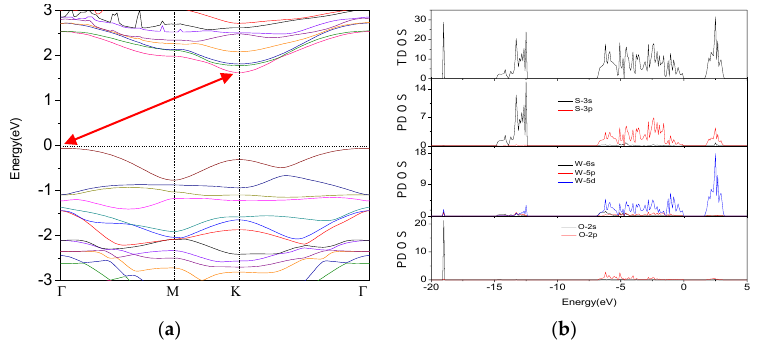
Figure 3. ( a ) Band structure of O-doped monolayer WS 2 and ( b ) TDOS and PDOS of O-doped monolayer WS 2 . The band gap are shown with red arrows.